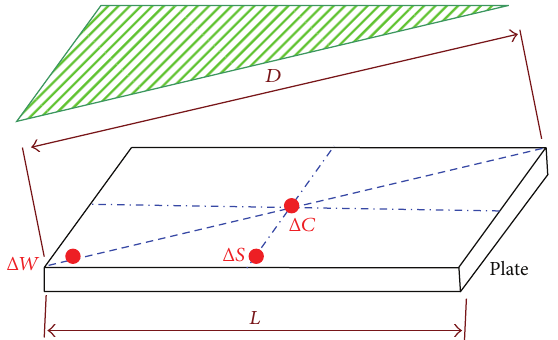
Table 3: The classification results of second specimen.